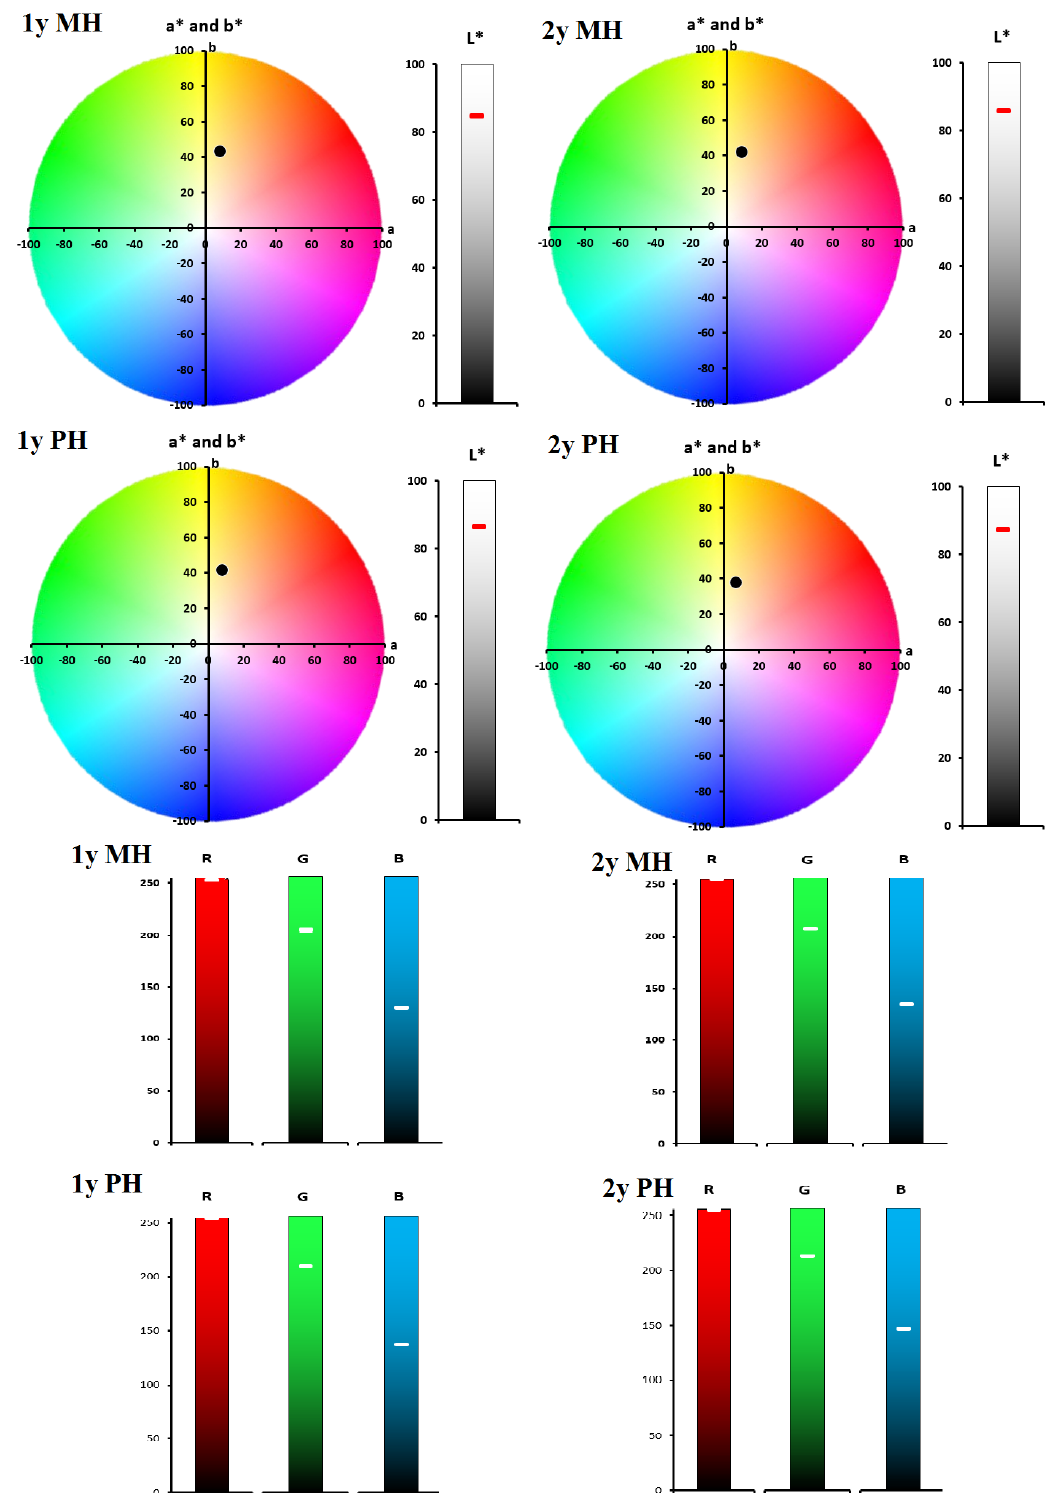
Figure 8. Color space for the control (MH) and plasma treated (PH) Hu¸si must, according to [83]. The black dots represent the points ( a* , b* ) of the samples, while the red horizontal line in the bar graphs represents the L* , R, G and B of the 1 and 2 year old